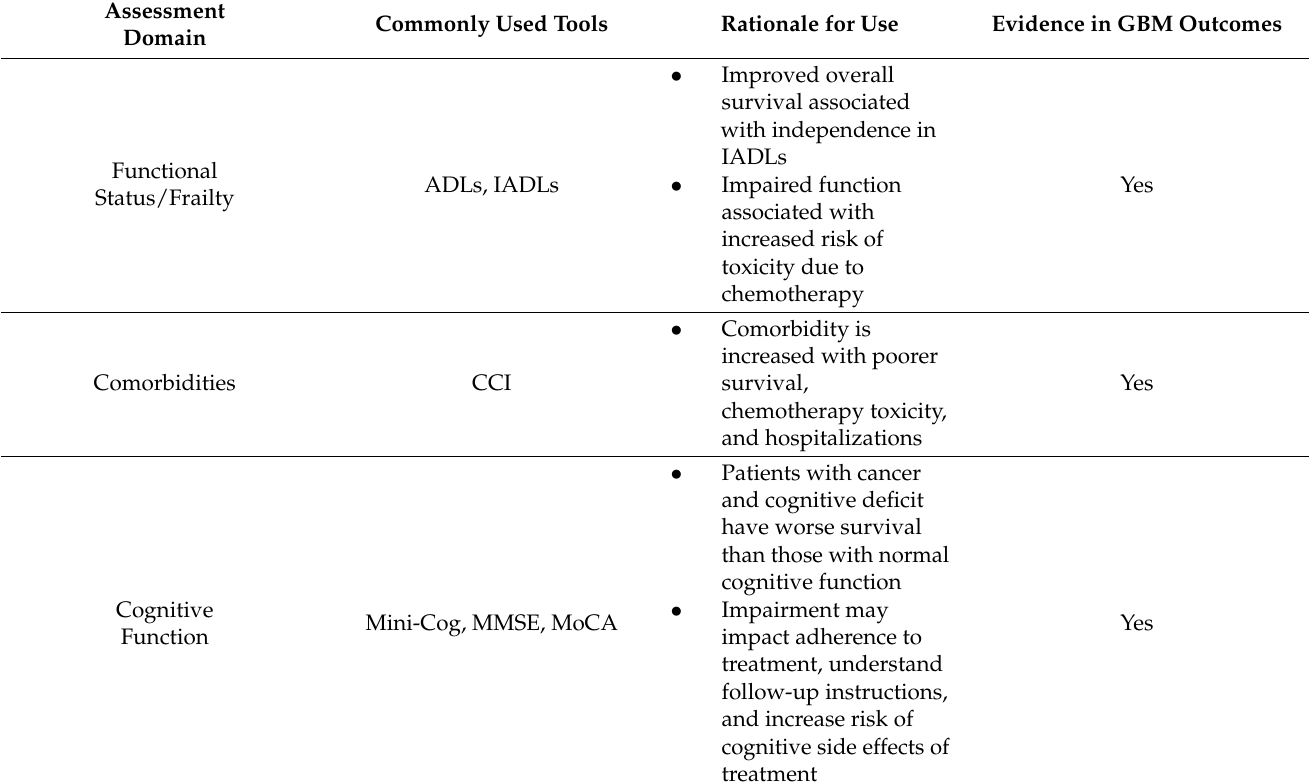
Table 2. Commonly assessed domains in the Comprehensive Geriatric